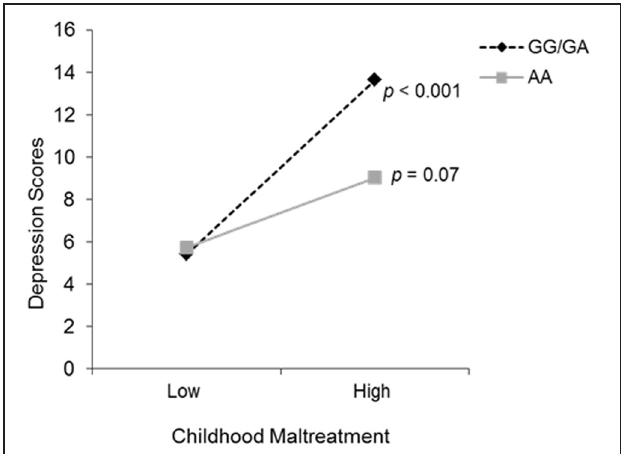
FIGURE 1 | The relation between childhood maltreatment and depression scores as a function of the OXTR rs53576 genotype (GG/GA vs. AA). The simple slopes analyses revealed that genotype groups did not differ at lower levels of childhood maltreatment. However, depressive symptoms increased significantly when higher levels of childhood maltreatment were experienced, but only among those individuals with the GG/GA genotype.